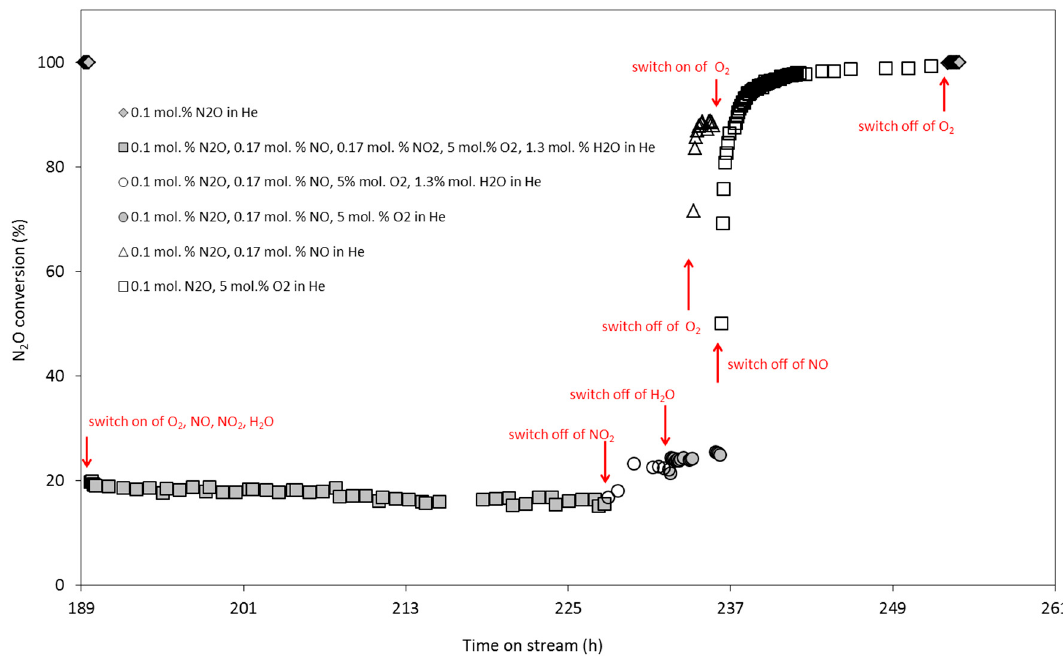
Figure6. Time-on-stream, N 2 Ocatalyticdecompositionindi ff erentreactionmixtureoverK / Co 4 MnAlO x Figure 6. Time-on-stream, N 2 O catalytic decomposition in different reaction mixture over calcined at 500 ◦ C. Conditions: 450 ◦ C, GHSV = 20 L g − 1 h − 1 K/Co 4 MnAlO x calcined at 500 °C. Conditions: 450 °C, GHSV = 20 L g − 1 h − 1 .